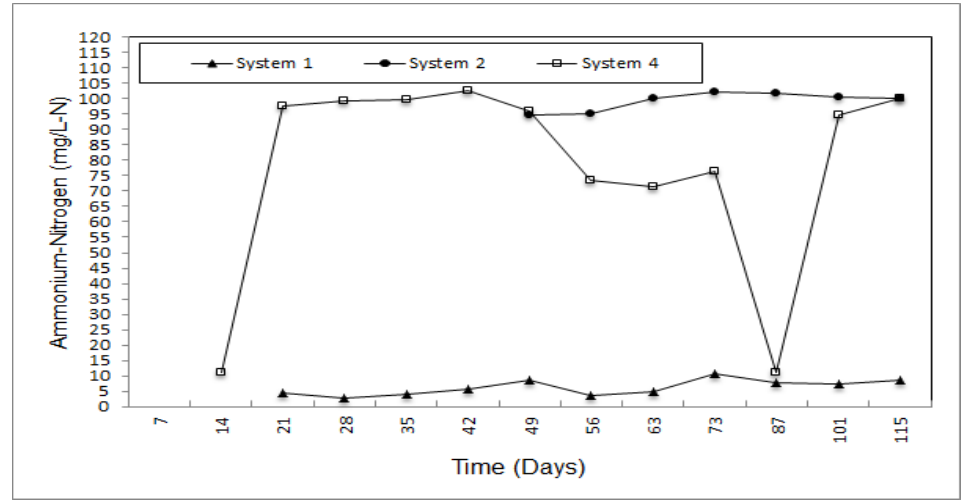
Figure 6. Ammonium-nitrogen concentration of the